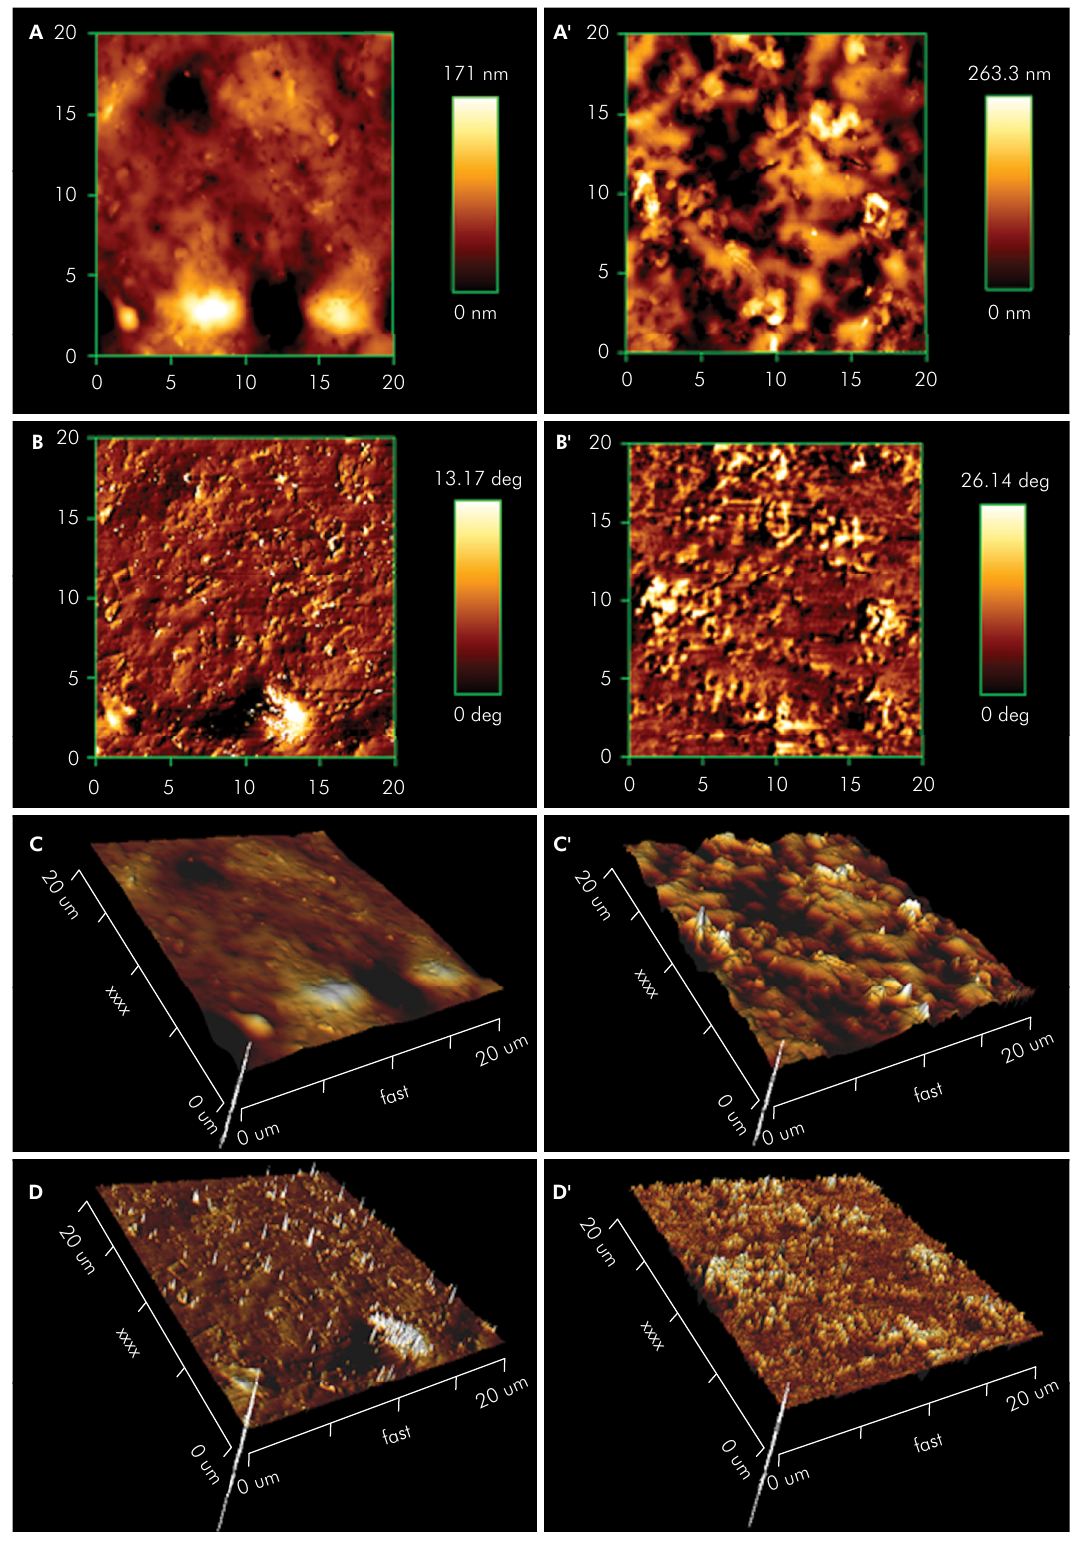
Figure 3. Photomicrographs in AFM of specimen surfaces from Group FUJI, before and after pH-cycling, respectively being: A and A’: two-dimensional images in height; B and B’: two-dimensional images of lock-in phase; C and C’: three-dimensional images in height; D and D’: three-dimensional images of lock-in